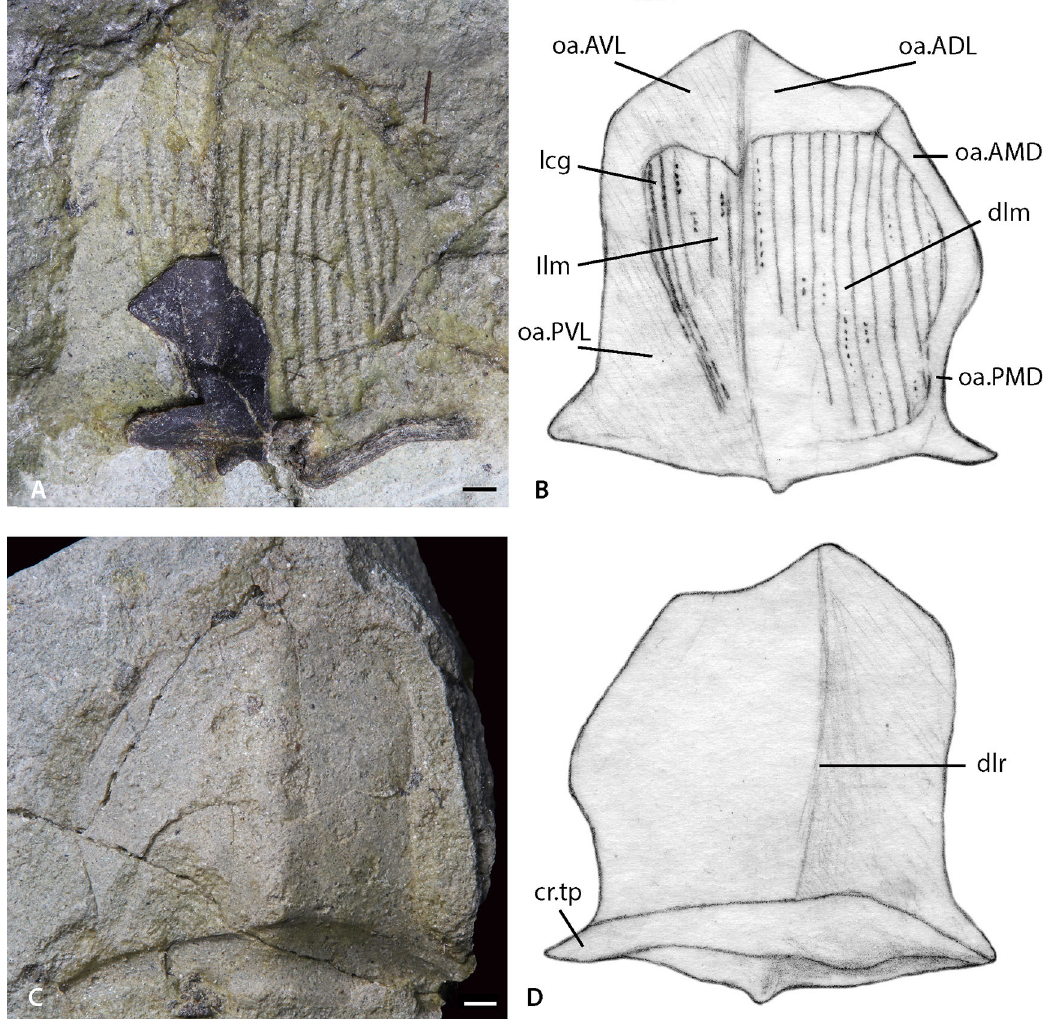
Fig. 7. Microbrachius kedoae from the Gavrilchitsy 45 borehole. Mixilateral plates. A , B , GIT 767-9 in visceral view with bone removed to show dorsal surface. C , D , GIT 767-10 in dorsal view with bone removed to show visceral surface. Scales bars = 1 mm. Abbreviations: ADL, anterior dorso-lateral plate; AMD, anterior median dorsal plate; AVL, anterior ventro-lateral plate; PMD, posterior median dorsal plate; PVL, posterior ventro-lateral plate; cr.tp, crista transversalis interna posterior; dlm, dorsal lamina; dlr, dorso-lateral ridge; lcg, main lateral line groove; llm, lateral lamina; oa.ADL, area overlapped by ADL; oa.AVL, area overlapped by AVL; oa.AMD, area overlapped by AMD; oa.PMD, area overlapped by PMD; oa.PVL, area overlapped by